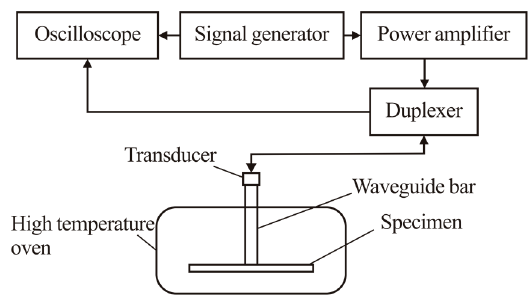
Figure 7. The sketch map of the experimental system.